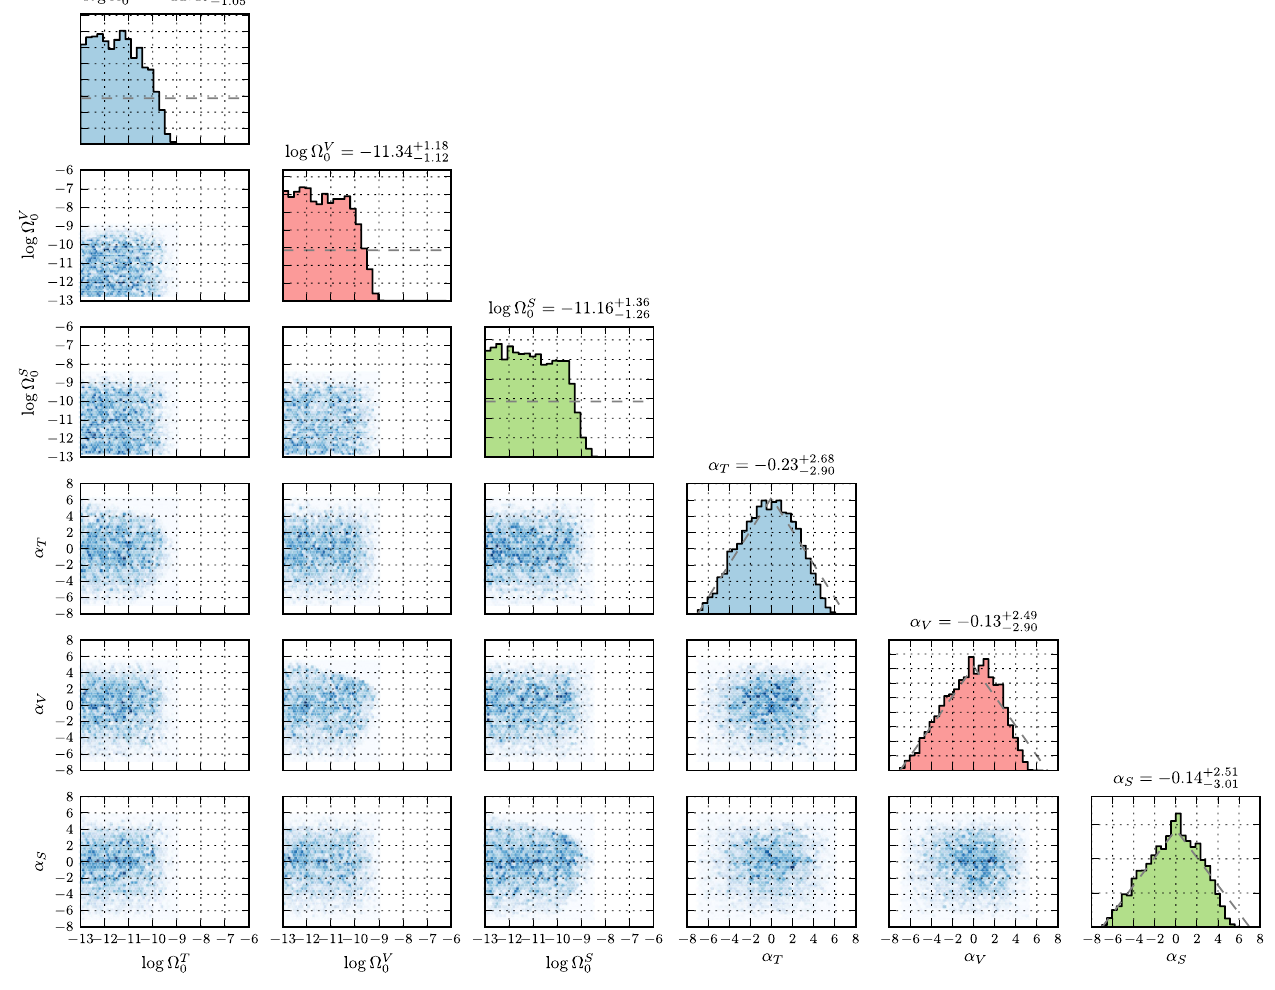
FIG. 10. Posteriors obtained for a simulated Advanced LIGO observation of pure Gaussian noise (case 1 in Table I), under the TVS hypothesis. The subplots along the diagonal show marginalized posteriors for the amplitudes and slopes of the tensor, vector, and scalar backgrounds (blue, red, and green, respectively), while the remaining subplots show the 2D posterior between each pair of parameters. Above each marginalized posterior we quote the median posterior value and (cid:4) 34% credible uncertainties. Each amplitude posterior is consistent with our lower prior bound, reflecting the nondetection of a stochastic background.